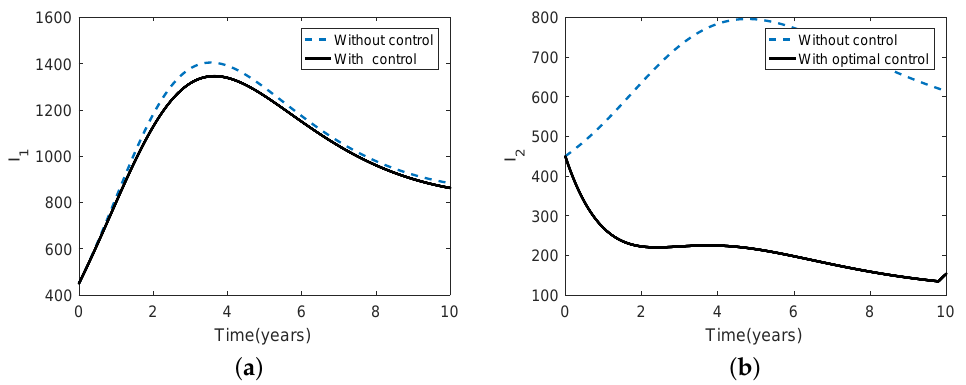
Figure 4. Numerical illustrations depicting the effects of optimal intervention strategies on controlling the long-term brucellosis dynamics for scenario 1 under strong asymmetric coupling ( a ) the numbers of infected animals in patch 1 ( b ) the numbers of infected animals in patch 2. In all the figures the dotted blue and solid black curves represent the infected population, without and with control,